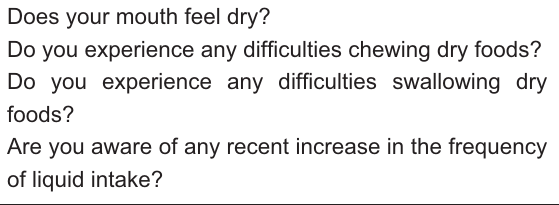
Does your mouth feel dry?